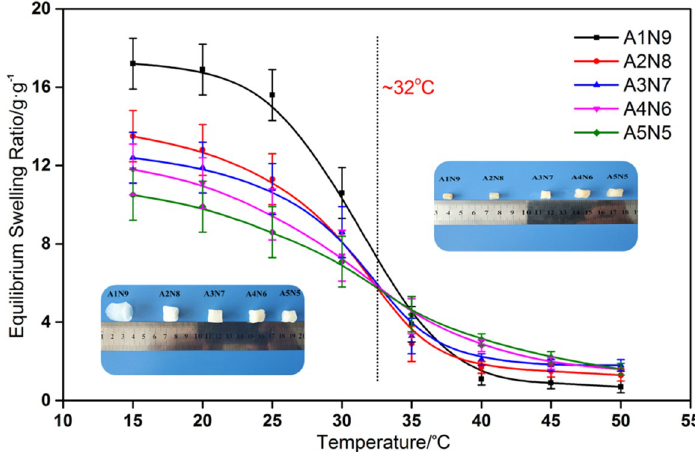
Figure 9. ESR for composite hydrogels in the temperature range from 15 °C to 50 °C.